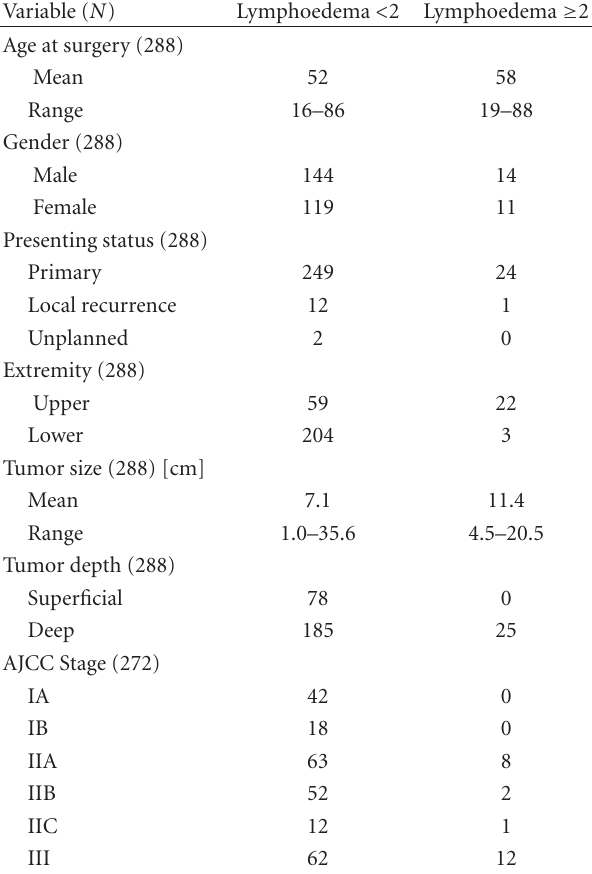
Table 3: Lymphoedema severity versus wound closure, tissue resec- ted, and comorbidities.